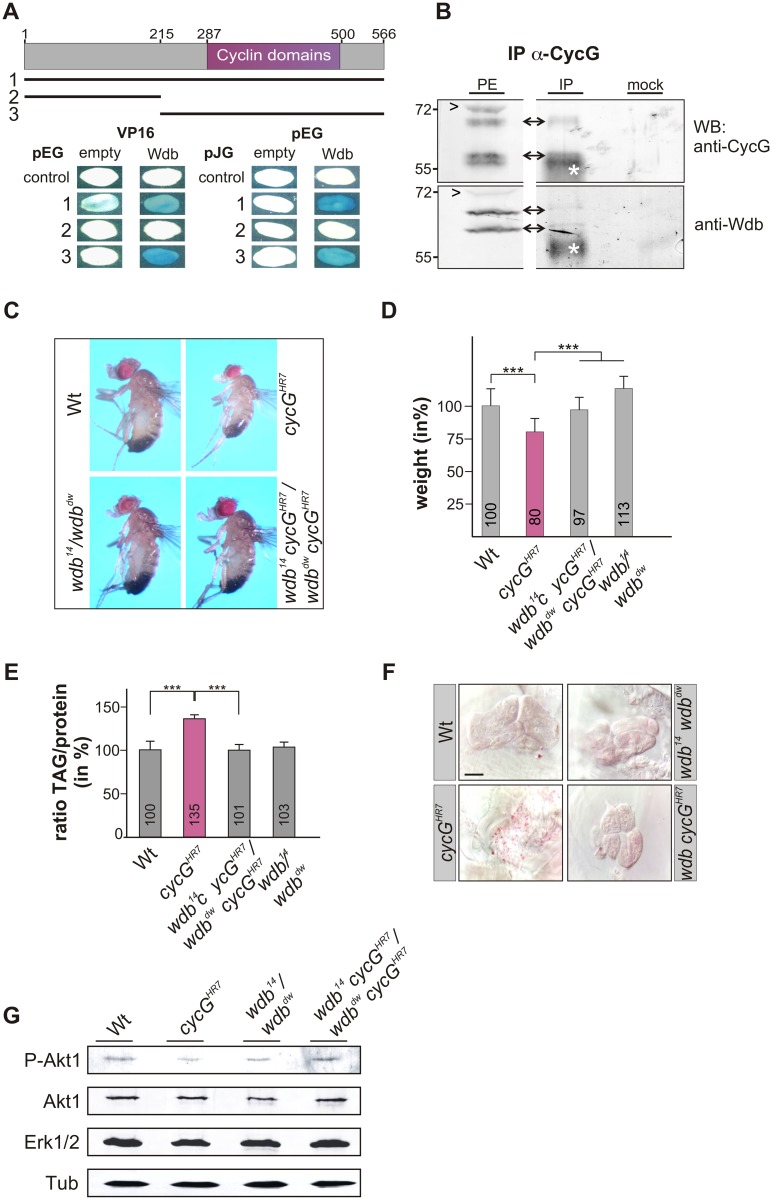
Interaction of CycG and Wdb.(A) Schematic representation of the CycG protein. Three constructs were used in a yeast two-hybrid assay, the full length protein (1, AS 1–566), the N-terminal region (2, AS 1–215) or the C-terminal region including the conserved Cyclin domains shown in magenta (3, AS 215–566). The interaction assay was done in both orientations, with CycG cloned into pEG vector or pJG vector and full length Wdb in pEG or VP16 vector. Empty vectors served as negative controls. Positive interaction is visualized by the blue staining of yeast colonies. (B) CycG and Wdb proteins can be co-precipitated in vivo. CycG proteins were immunoprecipitated (IP) from embryonic extracts using guinea pig anti-CycG antibodies and were probed with anti-CycG (upper box, arrows) or anti-Wdb antibodies (lower box, arrows), both from rat. The input lane contained 25% of the protein extract (PE) used for the IP. Arrowheads point to unspecific signals. Guinea-pig preimmune serum was used as mock control. The asterisks label unspecific IgG signals. Blots were cut to allow for exposure adjustment of the input. Size is given in kDa. (C) wdb cycG double mutant animals retain normal body size. In contrast to the small homozygous cycG
HR7 males, wdb cycG double mutant animals (wdb
14
cycG
HR7/wdb
dw
cycG
HR7) are more similar to wild type (Wt) or trans-heterozygous wdb mutants (wdb
14
/ wdb
dw
) with regard to size. (D) The weight deficit of homozygous cycG mutants is significantly rescued in a wdb mutant background, relative to wild type (Wt, taken as 100%). Depicted are wild type (Wt), cycG
HR7 homozygous mutant, wdb
14
cycG
HR7/wdb
dw
cycG
HR7 and wdb
14
/ wdb
dw flies. Error bars denote standard deviation [n = 100 per genotype]. ***p<0.001 according to Student’s T-test. (E) Shown are relative larval TAG levels, normalized to total body protein content. Wild type (Wt) levels were taken as 100%. The highly increased TAG levels of the cycG
HR7 mutants are significantly reduced in wdb cycG double mutants to nearly wild type levels. Error bars denote standard deviation [n≥3 experiments per genotype]. ***p<0.001 according to Student’s T-test. (F) Lipid droplets are largely absent from oenocytes in well fed wild type control animals (Wt) in contrast to homozygous cycG
HR7. Loss of wdb activity largely normalized the lipid accumulation in the cycG
HR7 mutant. Genotypes are: Wild type (Wt), cycG
HR7 homozygous; wdb
14
/ wdb
dw trans-heterozygous; wdb
14
cycG
HR7/wdb
dw
cycG
HR7double mutant (wdb cycG
HR7). Scale bar: 20 μm. (G) The wdb cycG double mutants show nearly normal Akt1 phosphorylation levels. Protein extracts from heads of wild type (Wt), cycG
HR7, wdb
14
/ wdb
dw and wdb
14
cycG
HR7/wdb
dw
cycG
HR7 mutants were probed with antibodies detecting either the unphosphorylated (Akt) or phosphorylated form (P-Akt) of Akt1. Erk1/2 and beta-Tubulin (Tub) served as loading controls.